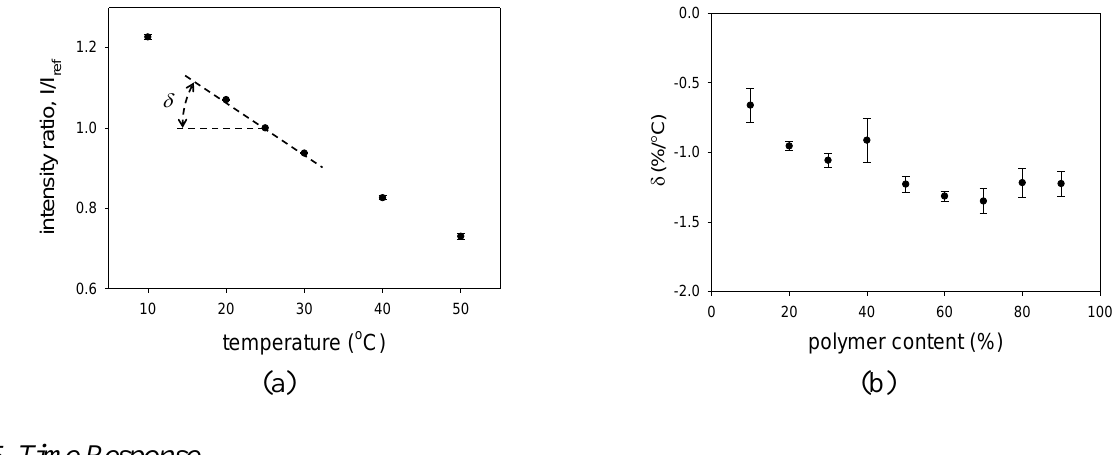
Figure 7. ( a ) The temperature calibration of PCPSP*. ( b ) Relationship between the temperature dependency,  (%/  C), and the polymer content (%).